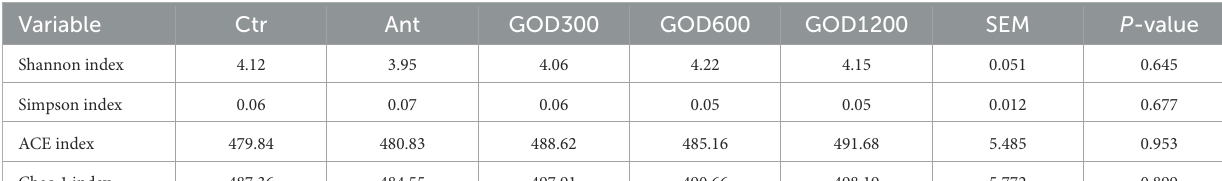
TABLE 8 Effects of GOD-supplemented feed on the cecal α -diversity of broilers.